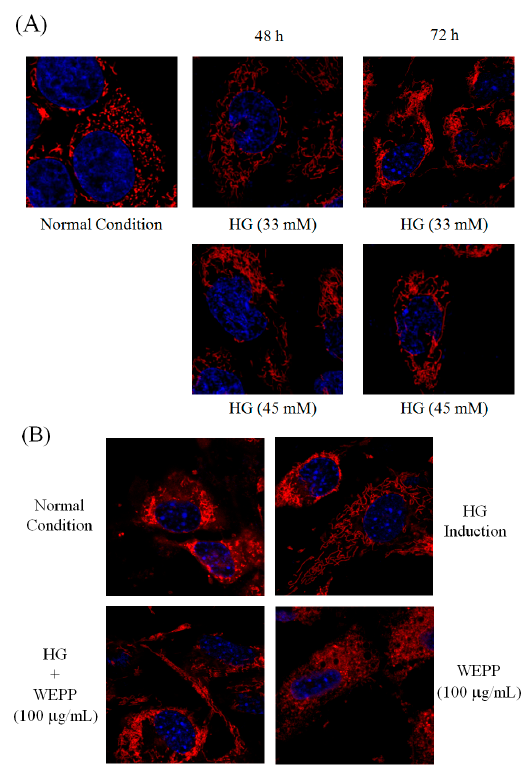
Figure 3. Observation of mitochondrial fission and fusion in OVCAR-3 carcinoma cells treated by ( A ) high glucose (HG) induction for 48 h and 72 h; or ( B ) HG induction with AEPP for 24 h. Fission: mitochondrial fragment; Fusion: mitochondrial network.